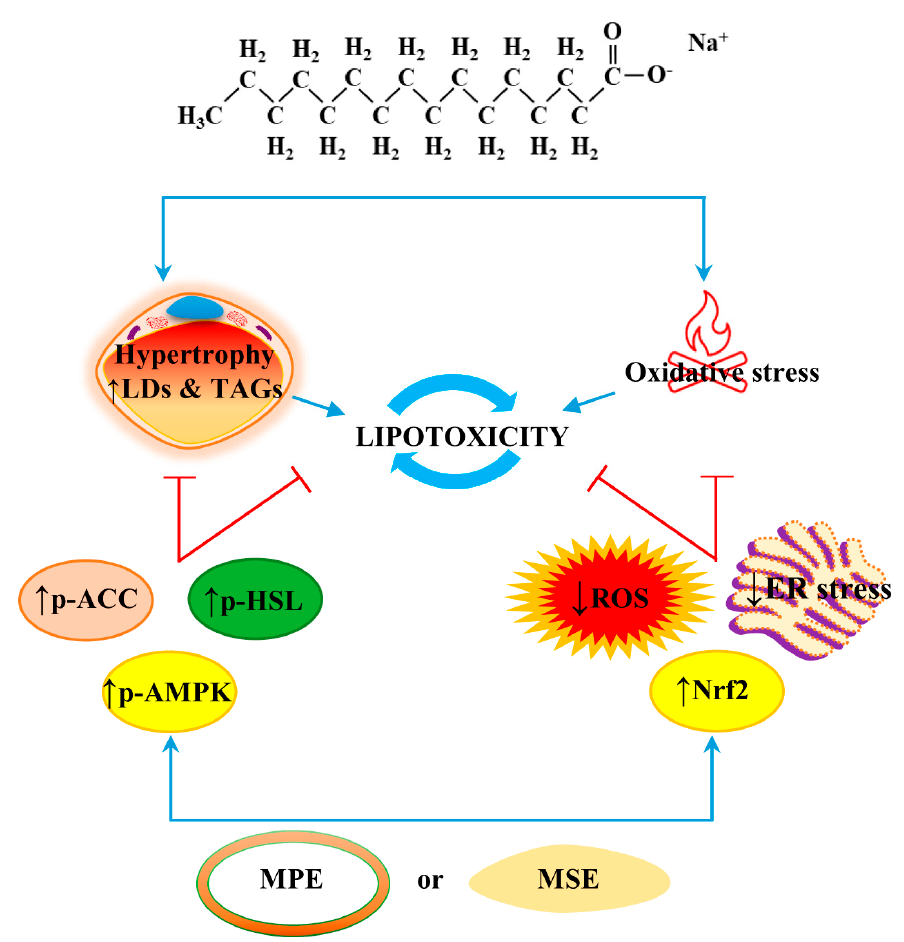
Figure 9. MPE and MSE counteracted lipotoxicity induced by PA in differentiated adipocytes. MPE and MSE lowered fat accumulation induced by high doses of PA in differentiated 3T3-L1 adipocytes, as demonstrated by the reduction of LD and TAG contents. These MPE and MSE anti-lipogenic effects seem to be mediated by the activation of HSL and inhibition of ACC as a result of AMPK activation. MPE and MSE also counteracted PA-induced ER stress and ROS increase in adipocytes. The anti-oxidative effects of MPE and MSE could be ascribed to the activation of the Nrf2/OH-1/MnSOD pathway. Reduced fat content and oxidative stress production could protect the cells from PA-induced cytotoxicity.